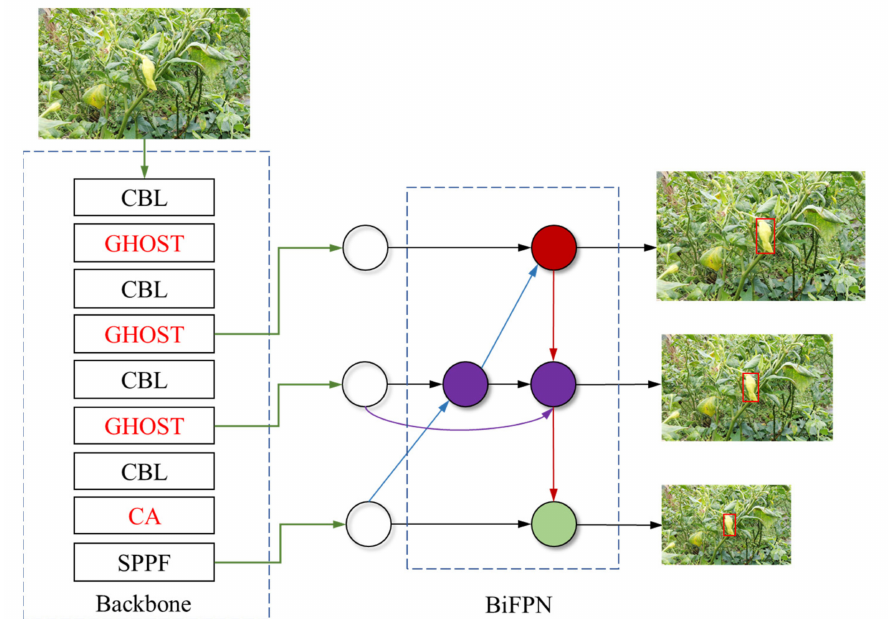
Figure 8. YOLOv5s-CFL network architecture. Modules marked in red represent improved parts in Backbone. The CSP module is replaced with GHOST. CA is inserted in the back of the backbone. The PANet is replaced with BiFPN to fuse the multi-scale features, and it is repeated once for efficiency. The outputs are on different